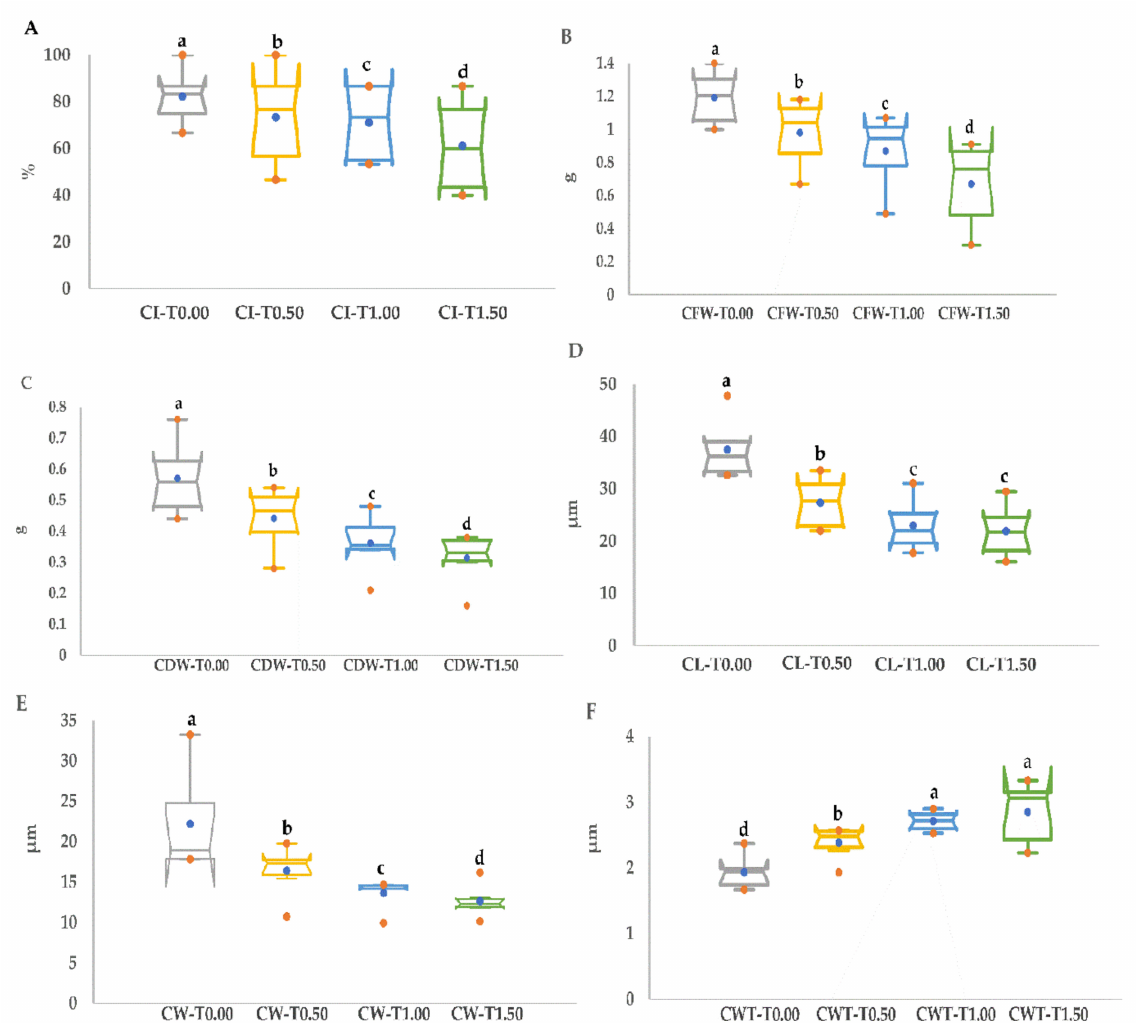
Figure 1. Box charts of growth characters of the kernel-derived calli from six rice genotypes, revealing the significant divergences between normal and stress conditions. ( A ). callus induction (CI), ( B ). callus fresh weight (CFW), ( C ). callus dry weight (CDW), ( D ). cell length (CL), ( E ). cell width (CW), and ( F ). cell wall thickness (CWT). The numbers given are the average values computed for the six measurements found for control (T0.00), and polyethylene glycol (PEG) concentrations (T0.5, T1.00, and T1.50). Di ff erent letters indicate a significant variation between box mean values by Duncan’s multiple-range analysis ( p ≤ 0.05). A blue dot in the box represents the mean value. Red dots denote the minimum and maximum values, while extreme values (outliers) are depicted as dots outside the